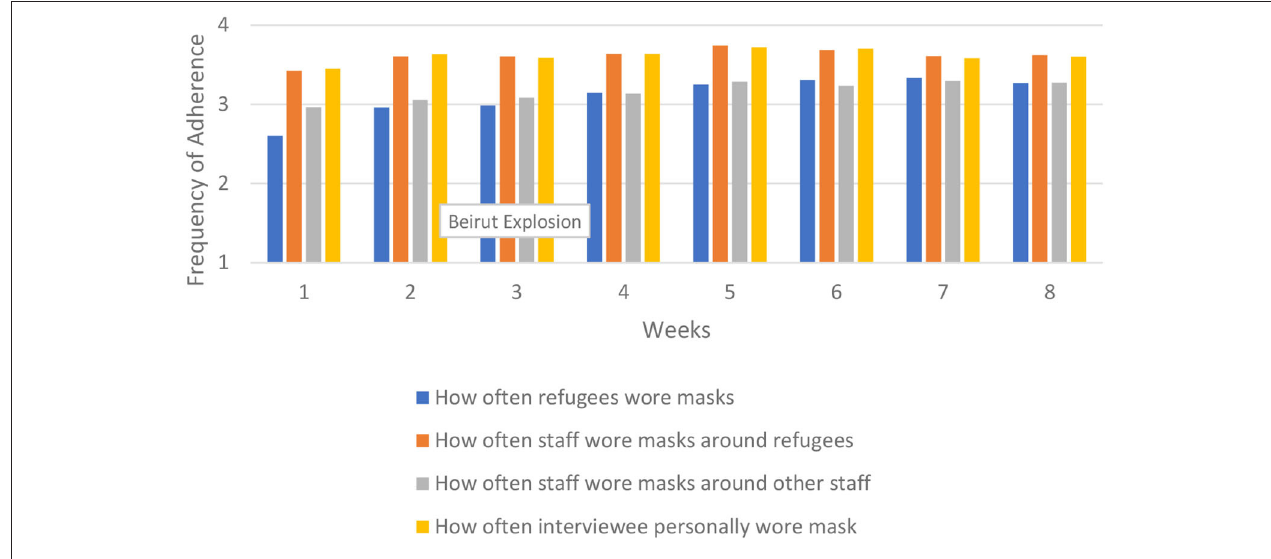
FIGURE 3 | Mask wearing across region.